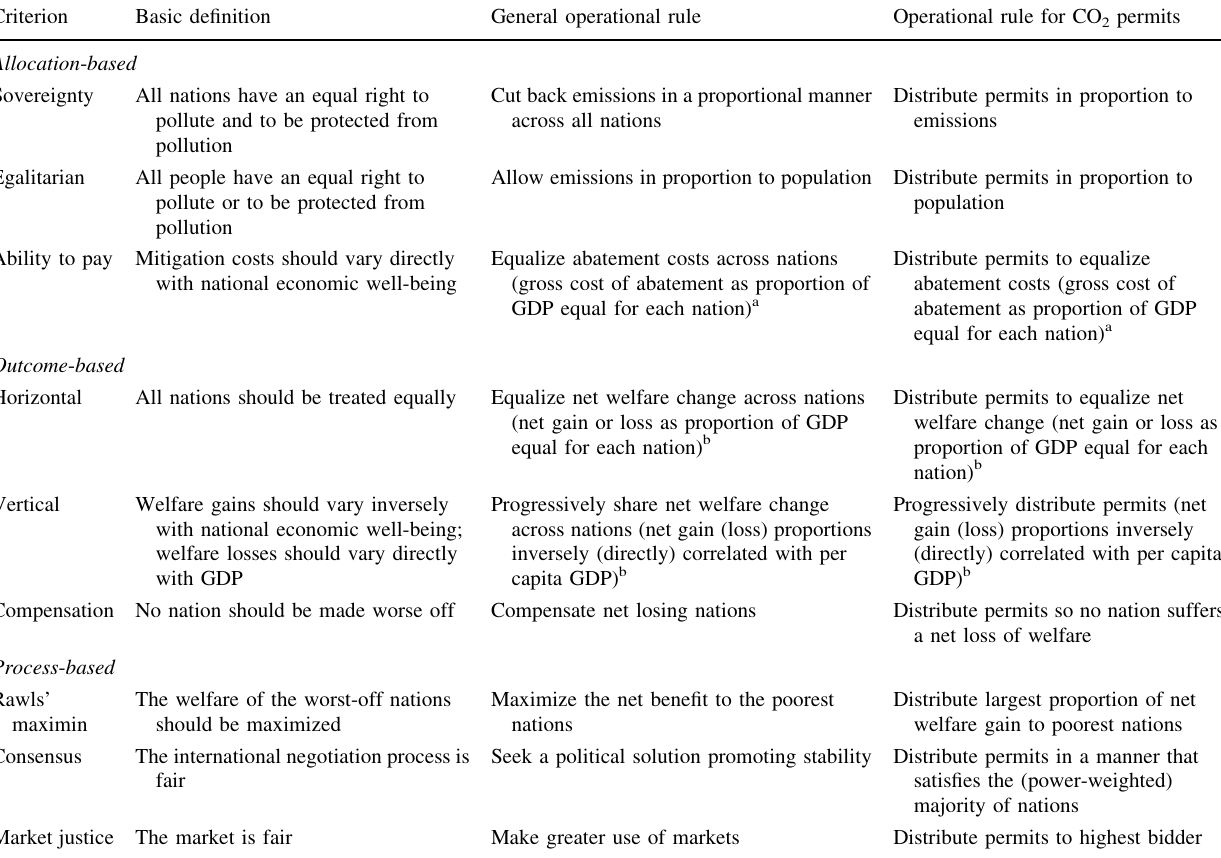
Table 1 Alternative equity criteria for global warming policy. Source Rose et al. (1998)